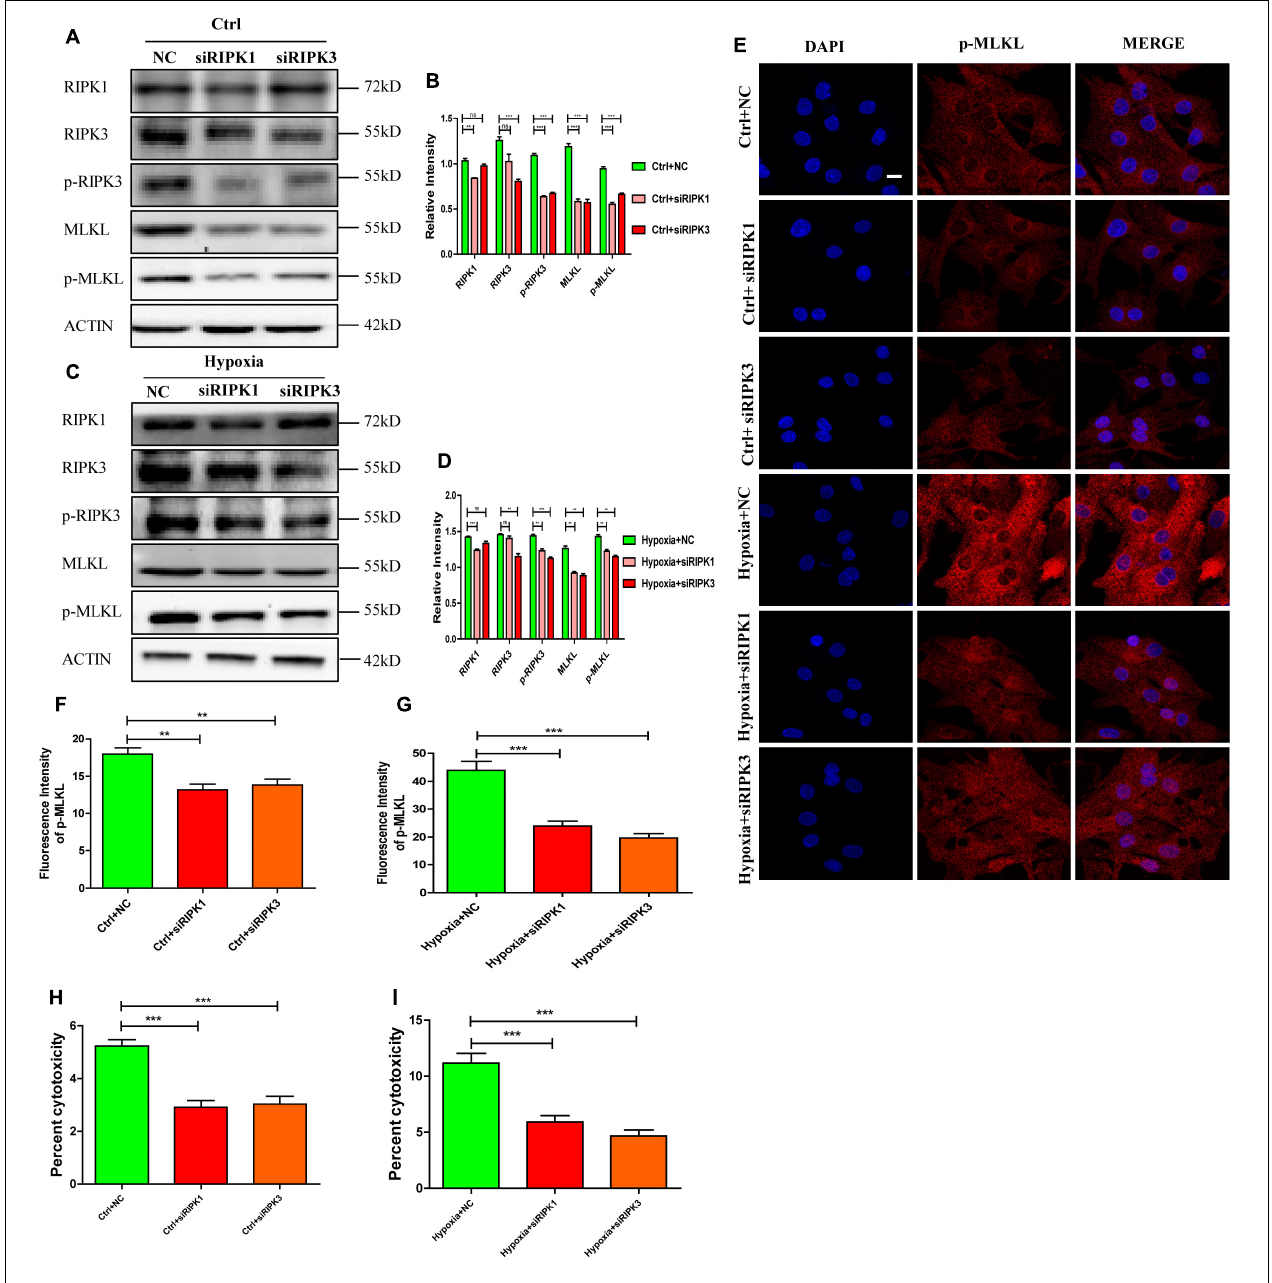
FIGURE 2 | RIPK1 and RIPK3 mediates necroptosis in hypoxic cardiomyocytes. (A–D) siRIPK1 and siRIPK3 were applied to disrupt necroptosis both under normoxia and hypoxia. Immunostaining bands and statistical analysis of RIPK1, RIPK3, p-RIPK3, MLKL, and p-MLKL in normoxic or hypoxic cardiomyocytes. Mean ± SEM, n = 3. Ns means no statistical difference, ** p < 0.01 and *** p < 0.001 versus the NC group. (E–G) . Representative confocal images and statistical analysis of p-MLKL in corresponding groups in panels (A–D) Scale bar, 10 µ m, Mean ± SEM, n = 3. ** p < 0.01 and *** p < 0.001 versus the NC group. (H) LDH leakage analysis was performed to determine cell death after addition of siRIPK1 and siRIPK3 under normoxia. Mean ± SEM, n = 5. *** p < 0.001 versus the NC group. (I) LDH leakage analysis was performed to determine cell death after addition of siRIPK1 and siRIPK3 under hypoxia. Mean ± SEM, n = 5. *** p < 0.001 versus the Hypoxia+NC